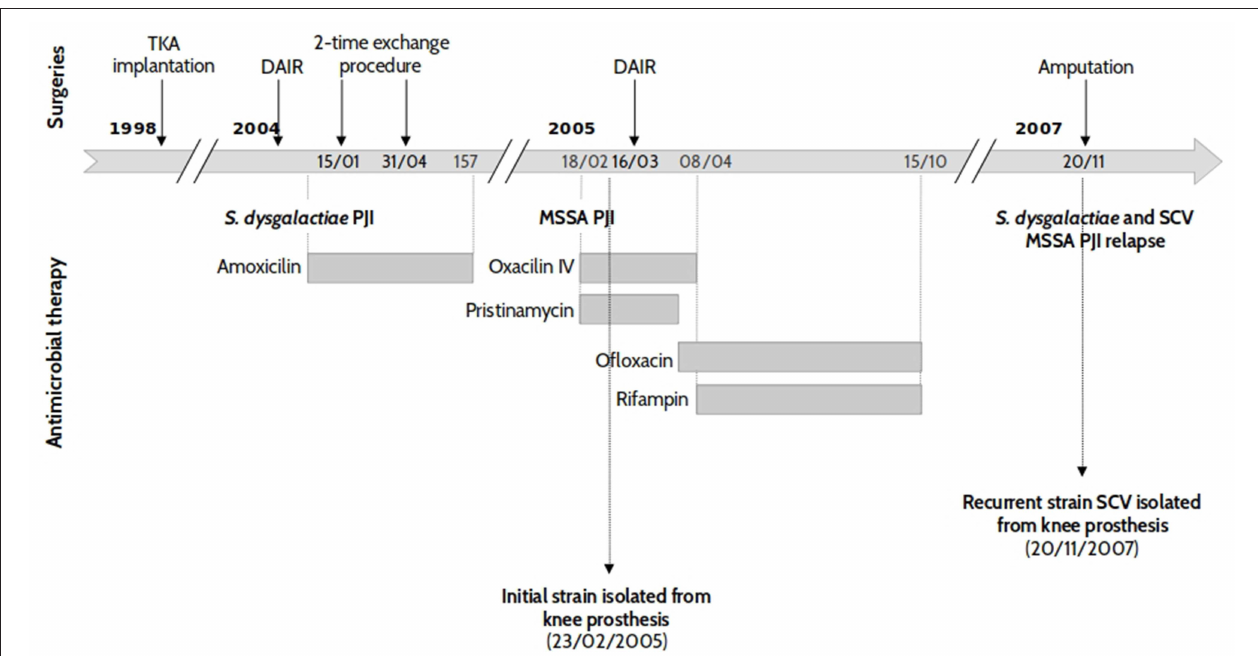
FIGURE 1 | Patient history case and chronology of isolate collection. Two strains of S. aureus (SA) sensitive to methicillin (MSSA) were isolated from an 83 year-old patient with left knee prosthetic joint infection. The first isolate (strain ST20130944) was collected during the first, acute SA infection, while the second was obtained 2 years and 9 months later during a recurrent episode.